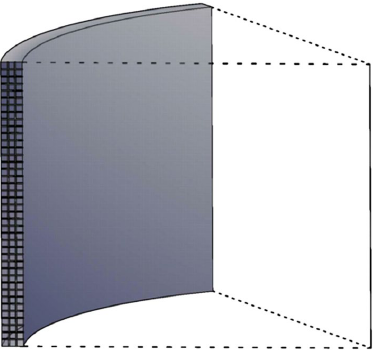
Fig. 3. An axisymmetric model of cylindrical shell